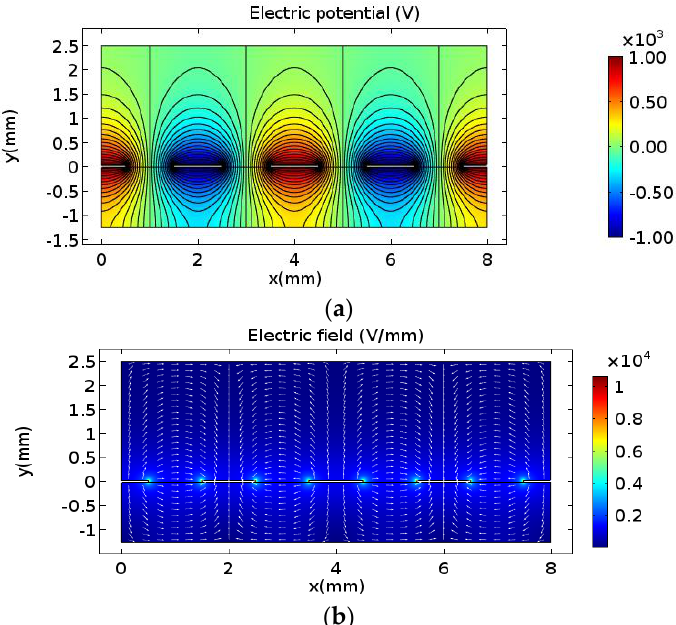
Figure 2. Distribution of electric potential ( a ) and electric field ( b ) obtained by numerical simulation at t = 0 s. Conditions: 𝑉 = 1000 V, 𝑓 = 50 Hz, and 𝜆 = 4